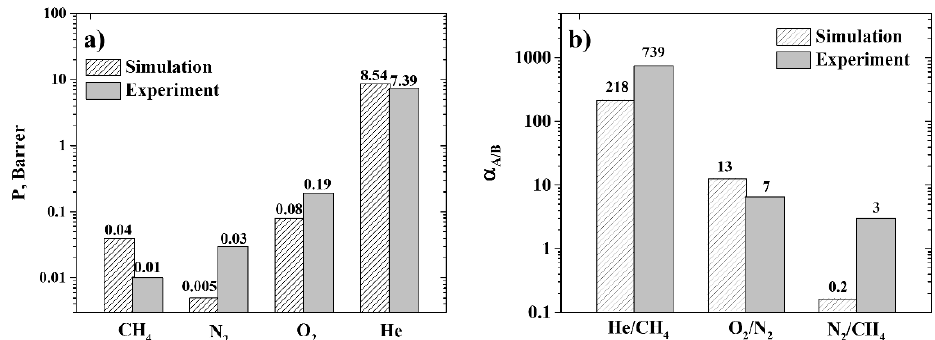
Figure 9. ( a ) Permeability of R-BAPB with respect to CH 4 , N 2 , O 2 , and He at T = 300 K. ( b ) Selectivity of R-BAPB for various gas pairs at T = 300 K, obtained in molecular dynamics simulations and in experiment. The results obtained in molecular dynamics simulations are shown by the shaded columns, and experimental data are given in the solid columns. Semi-logarithmic axes